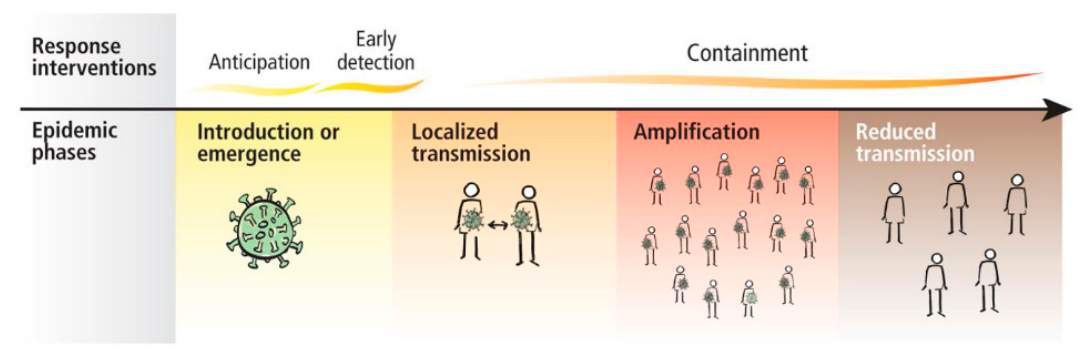
Figure 1. Operational considerations for case management of COVID-19 in health facility and